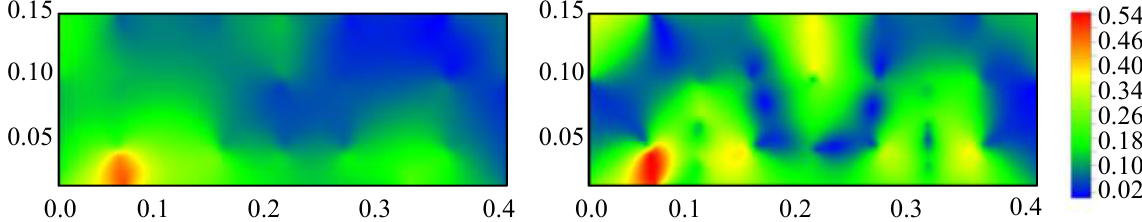
Figure 4—Pressure gradient distribution of HPVI without fractures and with fractures